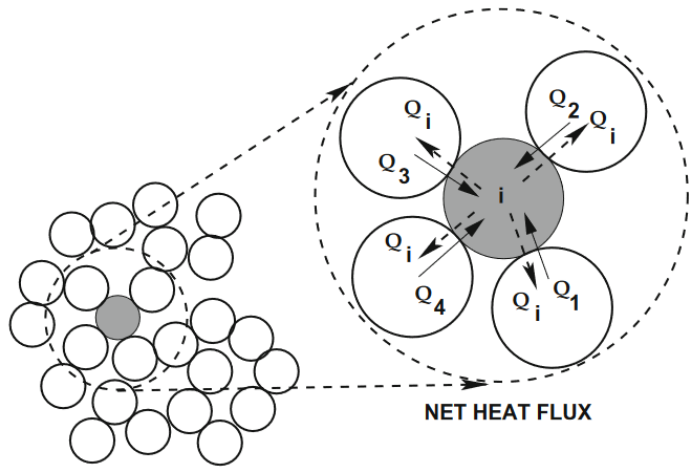
Figure 4. Heat flow exchange between particles.